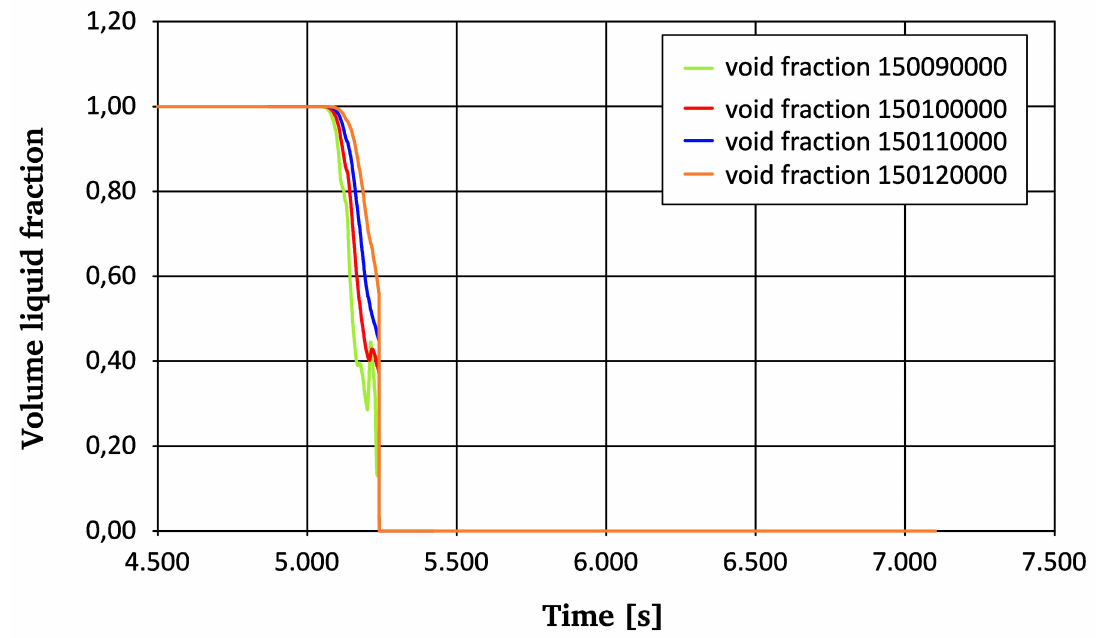
Figure 2. Draining phase in the collector [16].